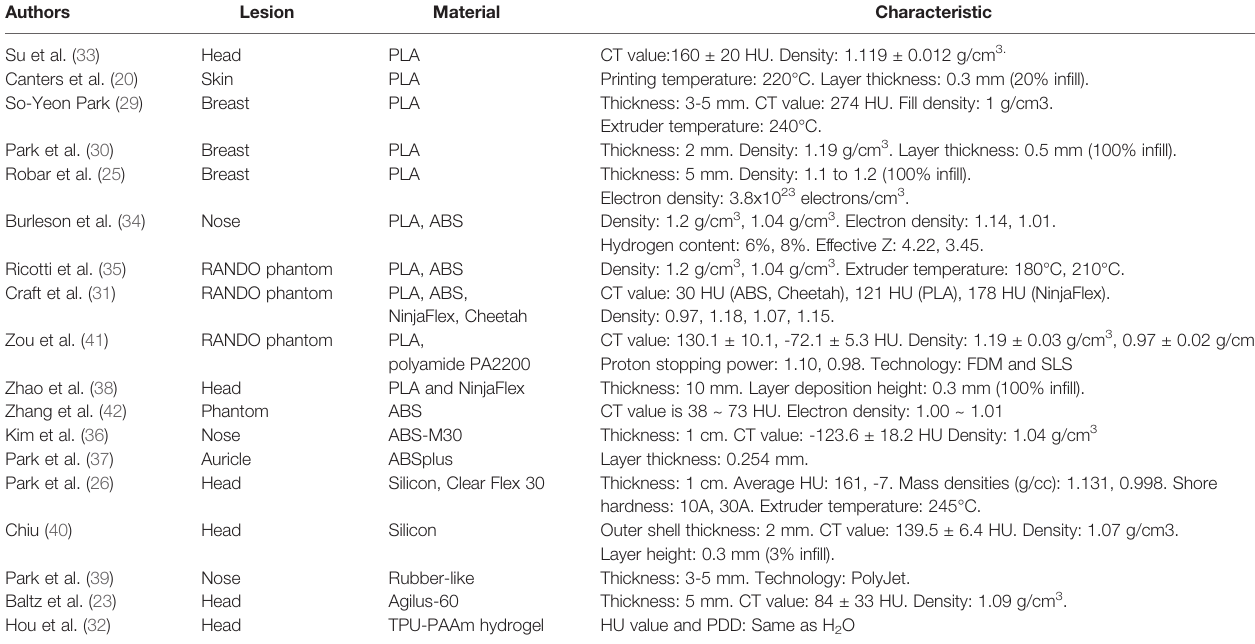
TABLE 1 | Different materials of the 3D-printed bolus.